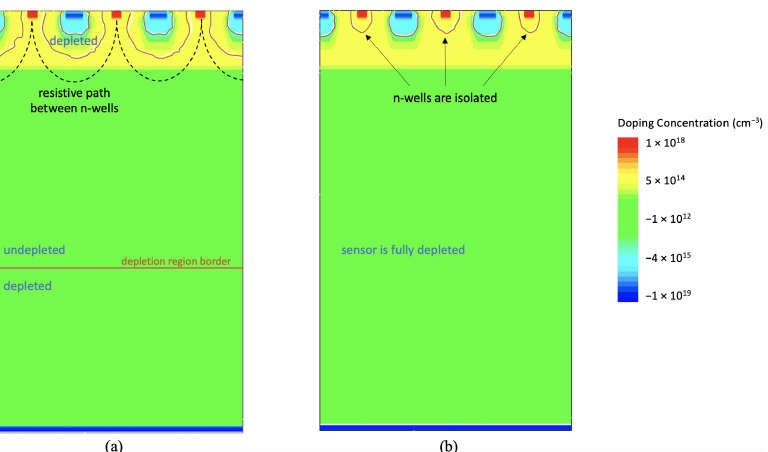
Figure 3. Depletion process in ARCADIA microstrips. ( a ): cross section of a sensor before full depletion is reached. ( b ): cross section of a fully depleted Monolithic Active Microstrip Sensors (MAMS). The orange lines indicate the edge of the depletion